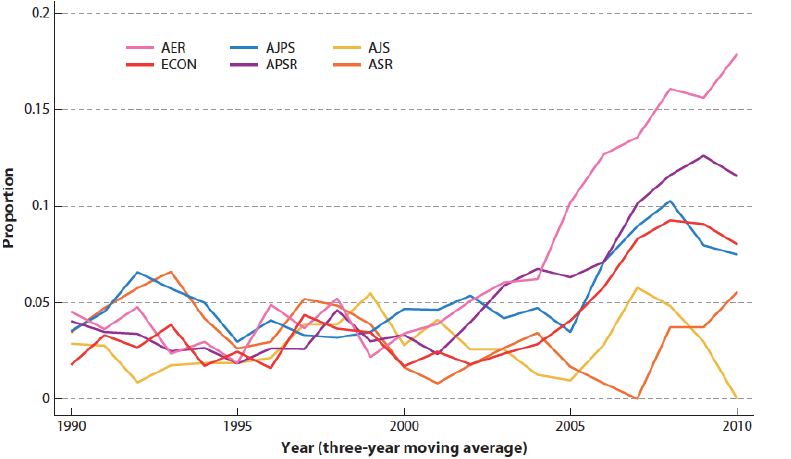
Figure 1. The proportion of research articles employing experimental design in top-ranked journals in economics, political science and sociology (three-year moving average). Abbreviations: AER, American Economic Review, ECON, Econometrica, AJPS, Amerinan Journal of Political Science, APSR, American Political Science Review, AJS, American Journal of Sociology, ASR, American Sociological